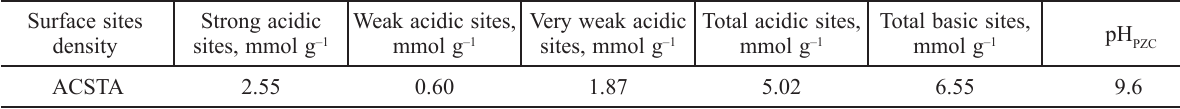
Table 2 – Acidic and basic surface sites density of ACSTA Surface sites